Question: What does this figure show? Answer in one sentence.
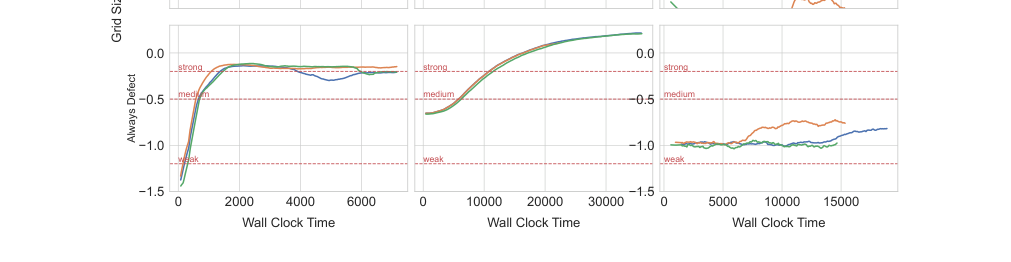
Answer: Training curves for 3 seeds of POLA and LOQA for 3x3, 4x4, 5x5 and 6x6 grid sizes on the two metrics in the Coin Game: Normalized return vs. each other and vs. always defect (AD). The wall clock time is measured in seconds. Note that the range of the x-axis is different for POLA, LOQA, and M-FOS as POLA and M-FOS take longer to pass the considered thresholds.